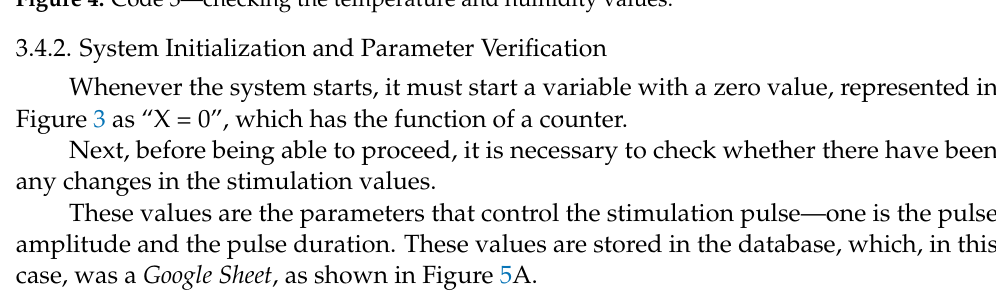
Figure 4. Code 3 — checking the temperature and humidity values.